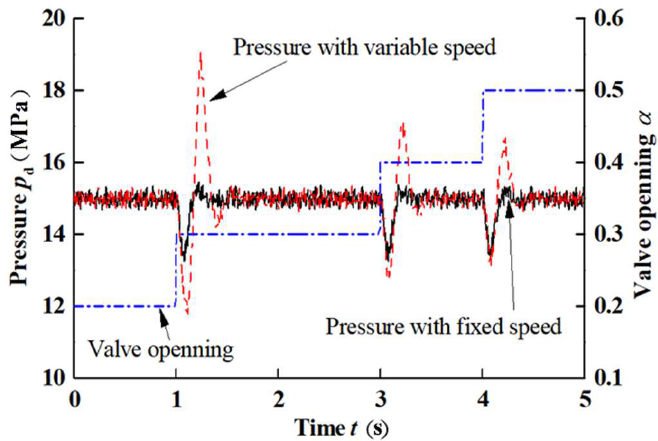
Figure 11. Pressure control compared with variable and fixed